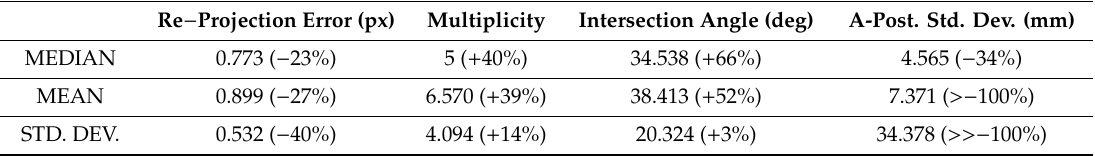
Table 9. Values of quality parameters computed on the filtered sparse point cloud (~187,000 3D tie points) and average variations of the metrics.